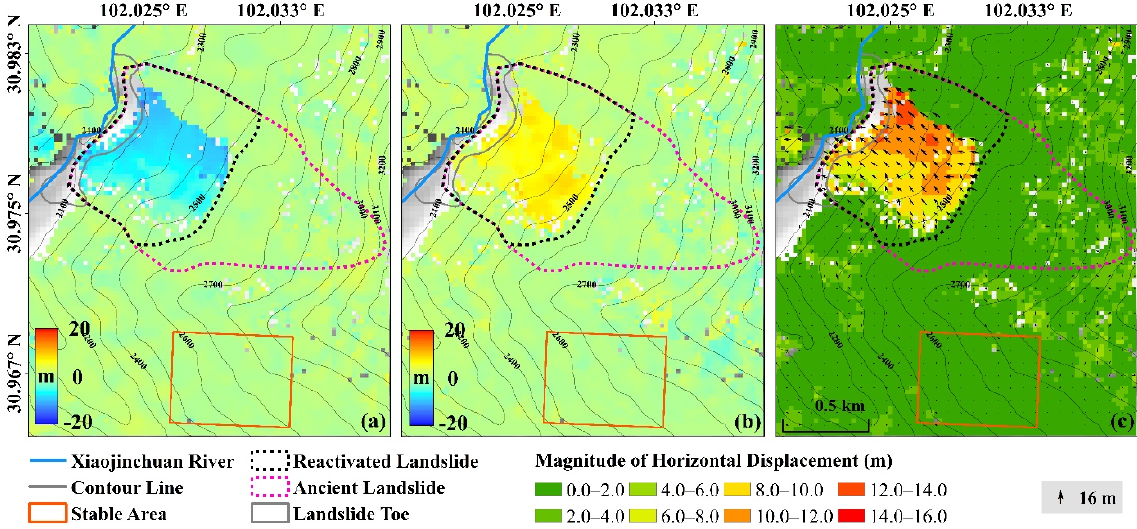
Figure 7. Post-failure deformation measured from image pair between 16 June 2020 and 24 June 24, acquired from the PlanetScope satellite: ( a ) west–east displacement; ( b ) north–south displacement; and ( c ) magnitude of horizontal displacement covered by the proportional black arrows indicating moving direction.